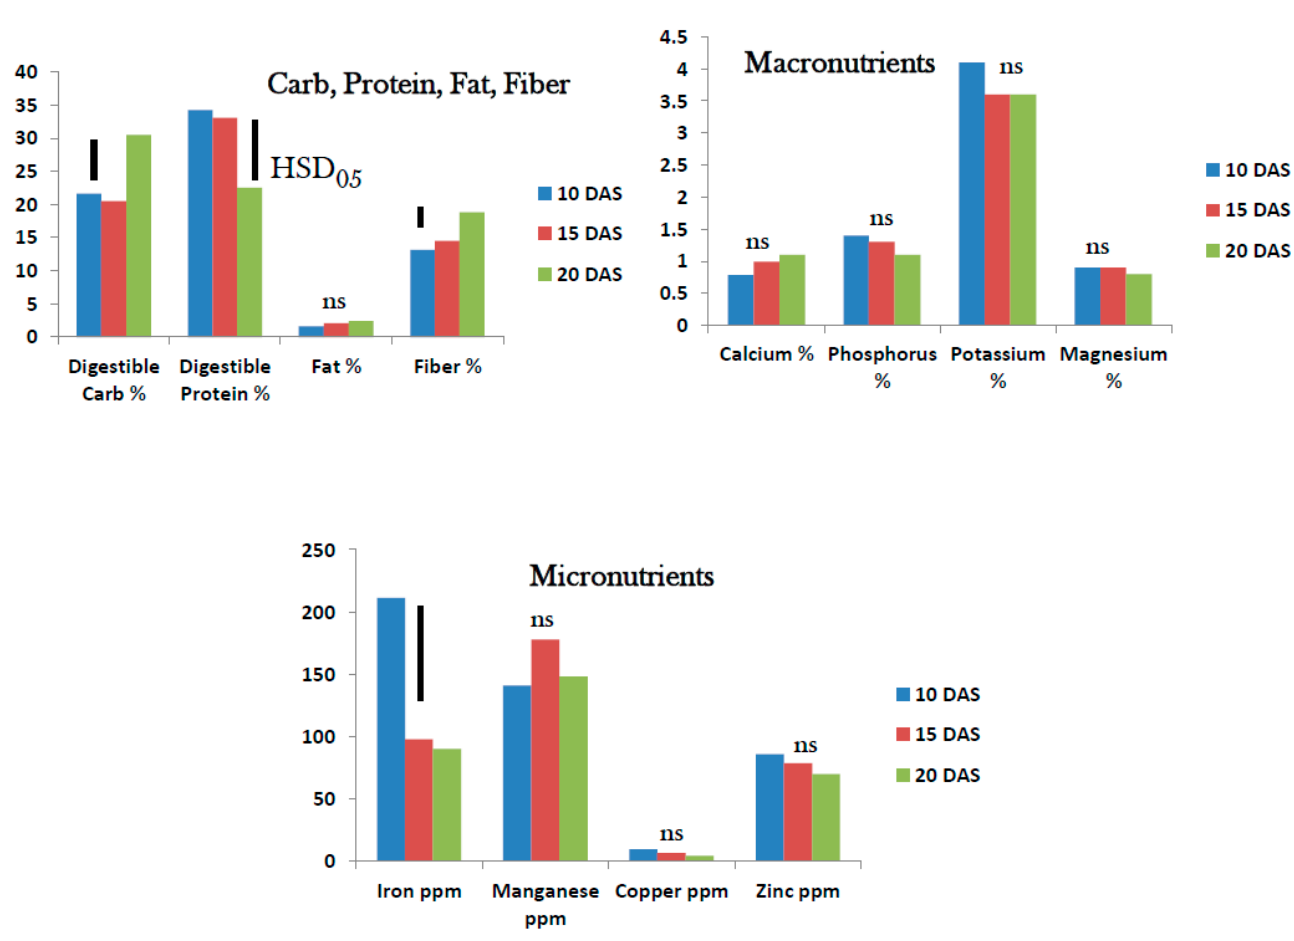
Figure 4. Roselle micro/baby-green: Nutrient status 10–20 days after seeding (DAS) (ns = no significant difference; bars show Tukey’s HSD at α = 0.05).